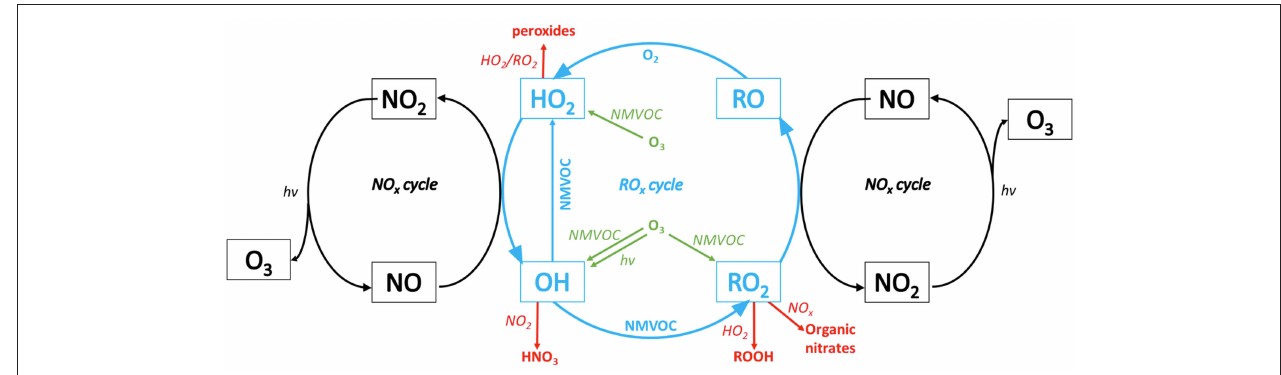
FIGURE 1 | Ozone formation via the interactions between the RO x - (blue) and NO x -cycles (black). Interfering with the RO x -NO x cycle are ozone degrading reactions (green) via NMVOCs (non-methane volatile organic compounds) as well as terminating reactions (red); h ν , light. Methane and carbon monoxide are not displayed (modified after Wang et al., 2017 with